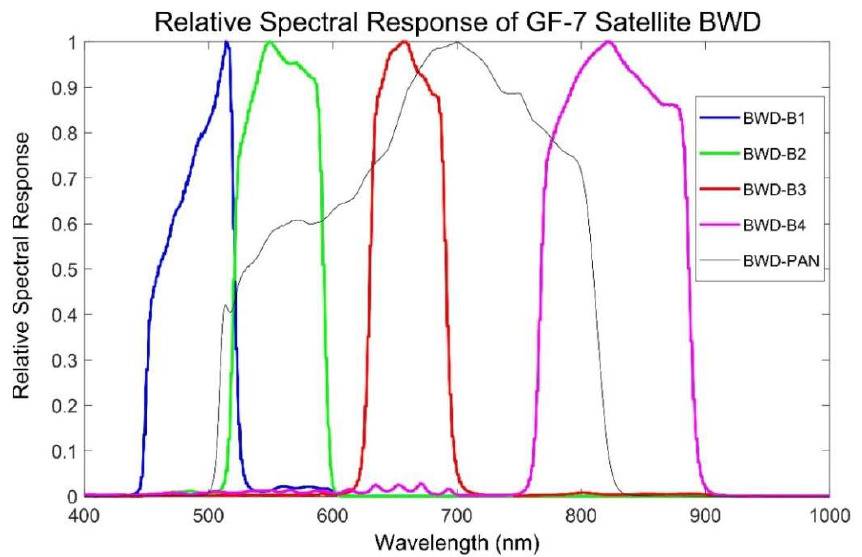
Figure 2. Normalized spectral response function of the GF-7 backward-looking camera.